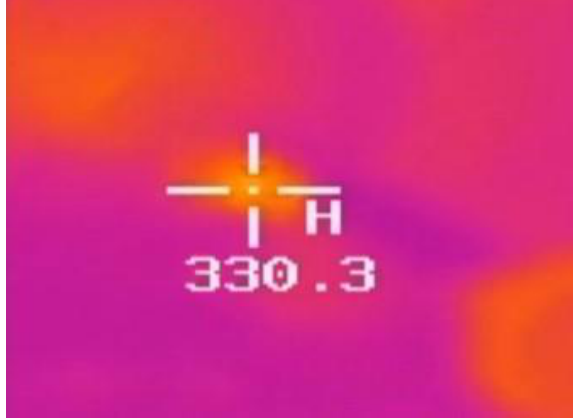
Figure 4. Cutting temperature thermal imaging.